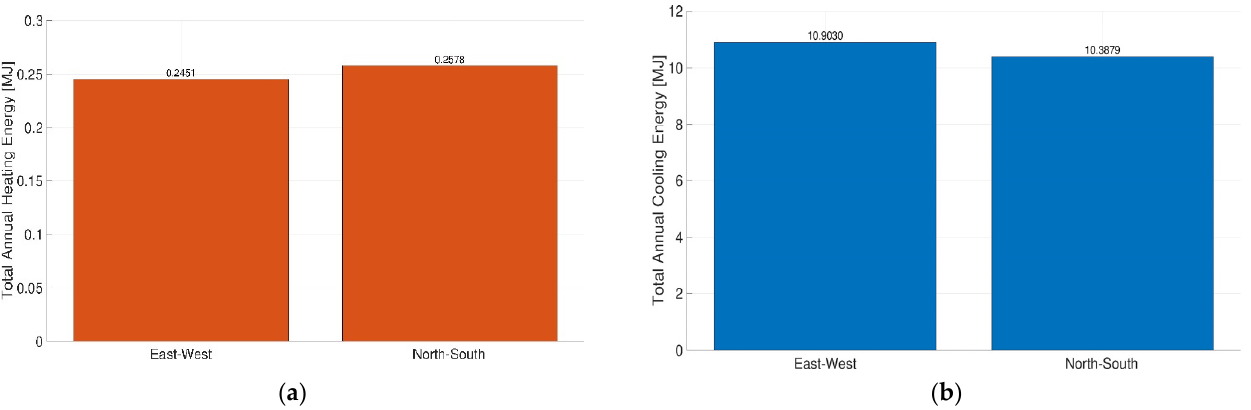
Figure 7. Ideal annual energy required for ( a ) heating and ( b ) cooling for the different glazing ma- terials (using North-South orientation with an Even-Span shape).